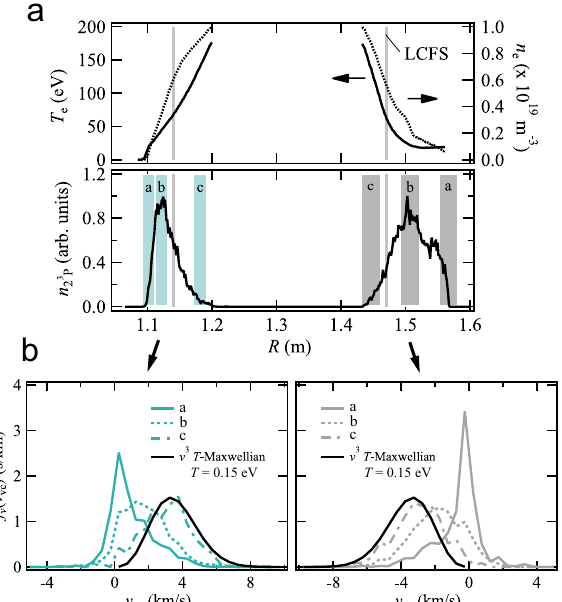
Figure 4. ( a ) n 2 3 P along the viewing chord. ( b ) Spatially resolved f ( v vc ) at shaded regions a, b, and c. The solid black lines indicate the “ v 3 ” T -Maxwellian distribution at T = 0.15 eV, which is the assumed initial distribution at the FWs.